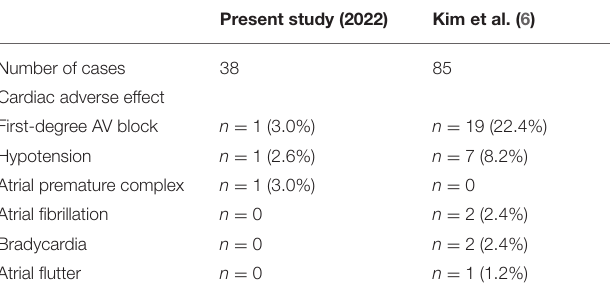
TABLE 5 | Comparison with previous study by Kim et al. Present study (2022) Kim et al.